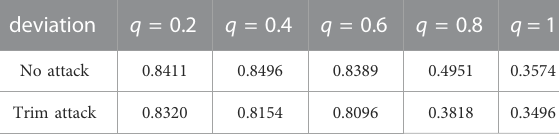
TABLE 5 The impact of data center sample distribution on accuracy.